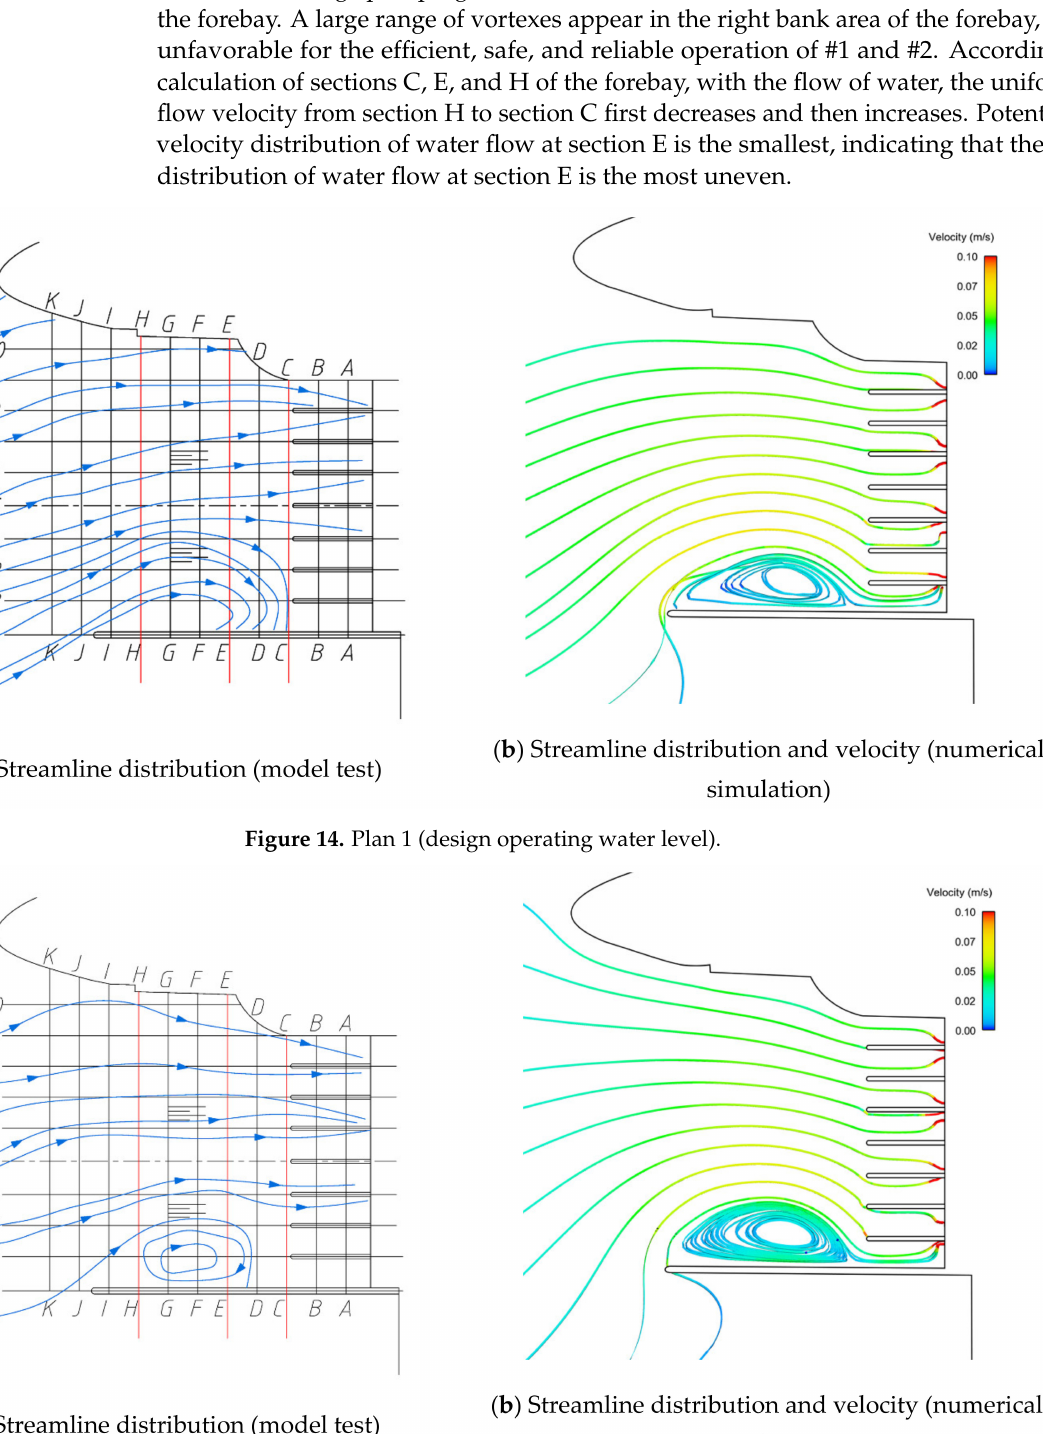
Figure 15. Plan 1 (flood control water